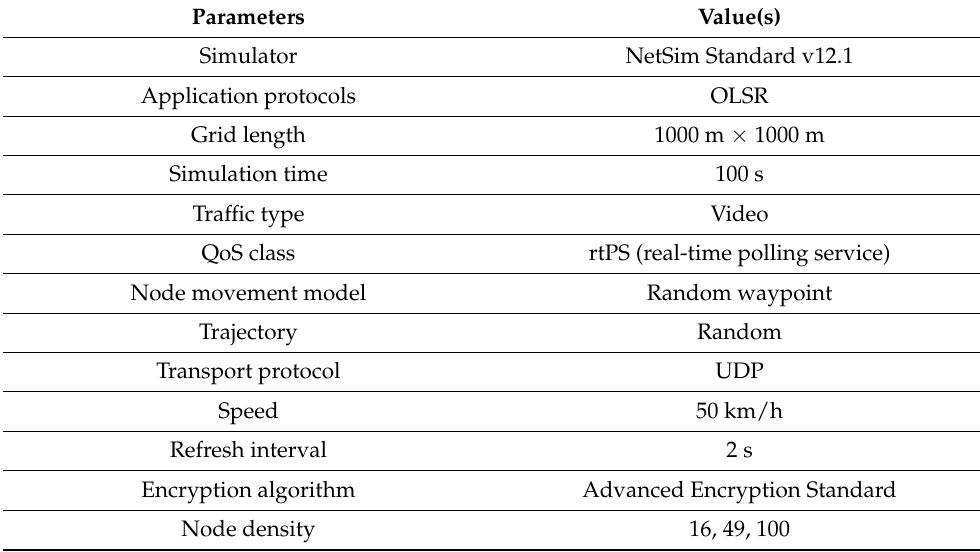
Table 2. Simulation